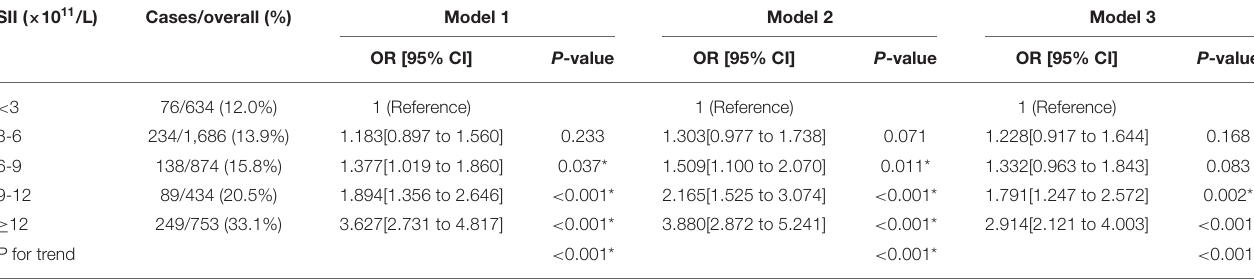
TABLE 3 | Logistic regression analyses of SII on the CI-AKI.